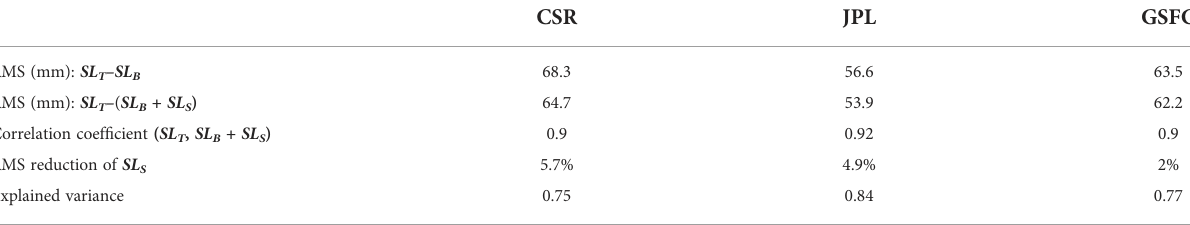
TABLE 1 Correlation and discrepancies between total sea level and the barystatic datasets and the sum of contributors in terms of